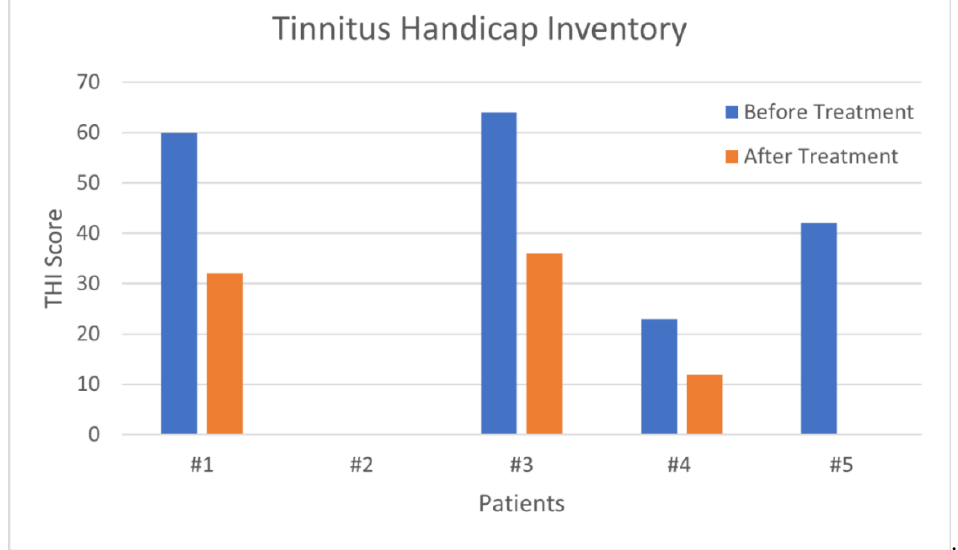
Figure 10. Each patient had an improved THI score after treatment; patient No. 2 was the only one to not experience tinnitus, and patient No.5 fully recovered from tinnitus.